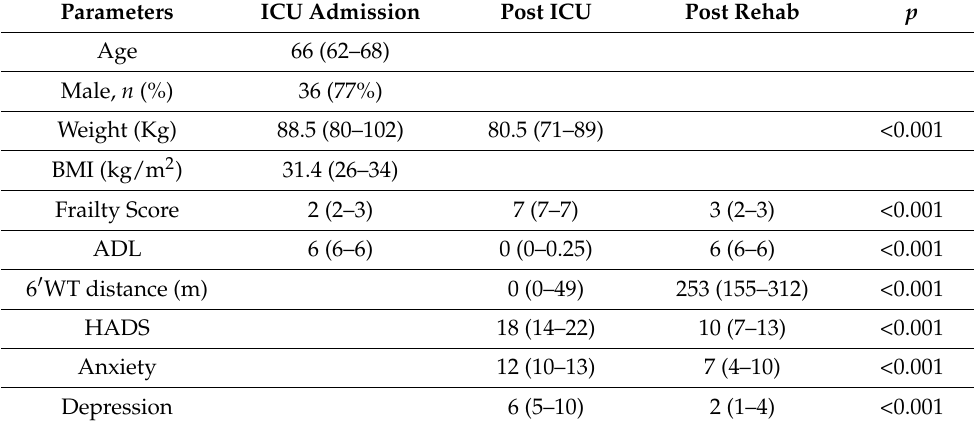
Table 1. Comparison of multidimensional outcome measures in 48 COVID-19 ARDS survivors between ICU admission, immediate post-ICU and the post-rehabilitation period.